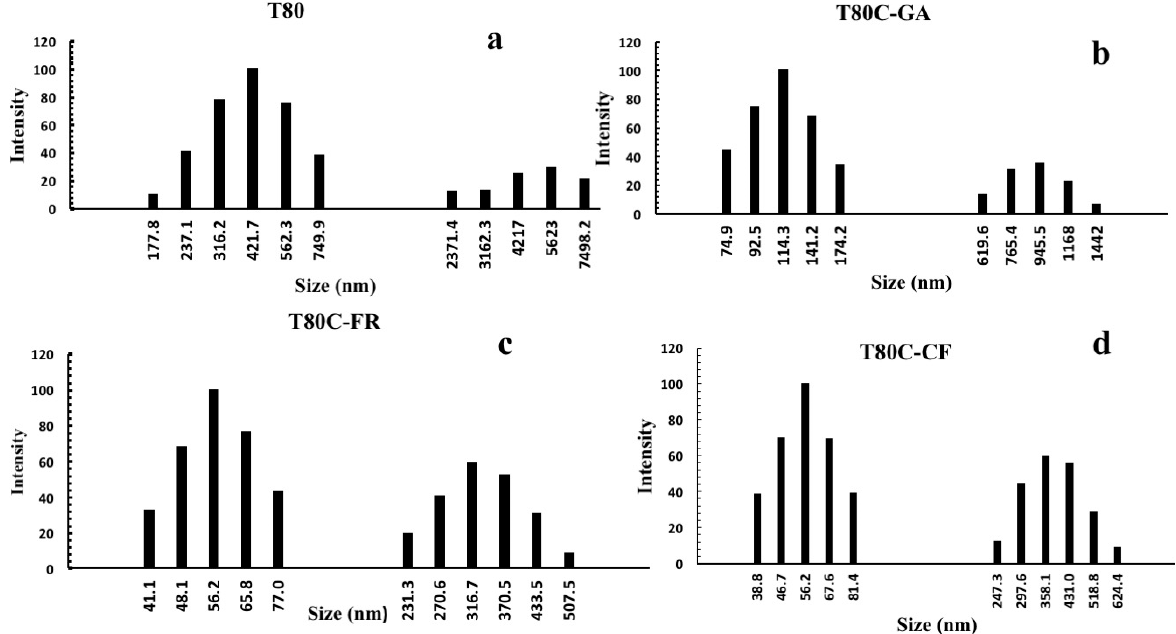
Figure 2. Size distribution of niosomes before ( a ) and after CUR loading and functionalization with GA ( b ), FR ( c ), and CF ( d ). Table 1. Average size, polydispersity index (P.I), zeta potential, and grafting efficiency of empty niosomes before and after conjugation with phenolic acids at 25 ◦ C. Data represent the mean ± S.D. of three independent experiments performed with triplicate